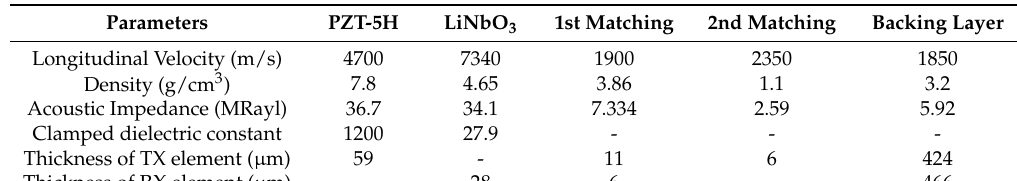
Figure 3. Structure of the proposed dual-element focused transducer. TX and RX stand for transmission and reception, respectively. Table 1. Material properties of piezoelectric materials, acoustic matching layers, and backing block used for the dual-element focused transducer.